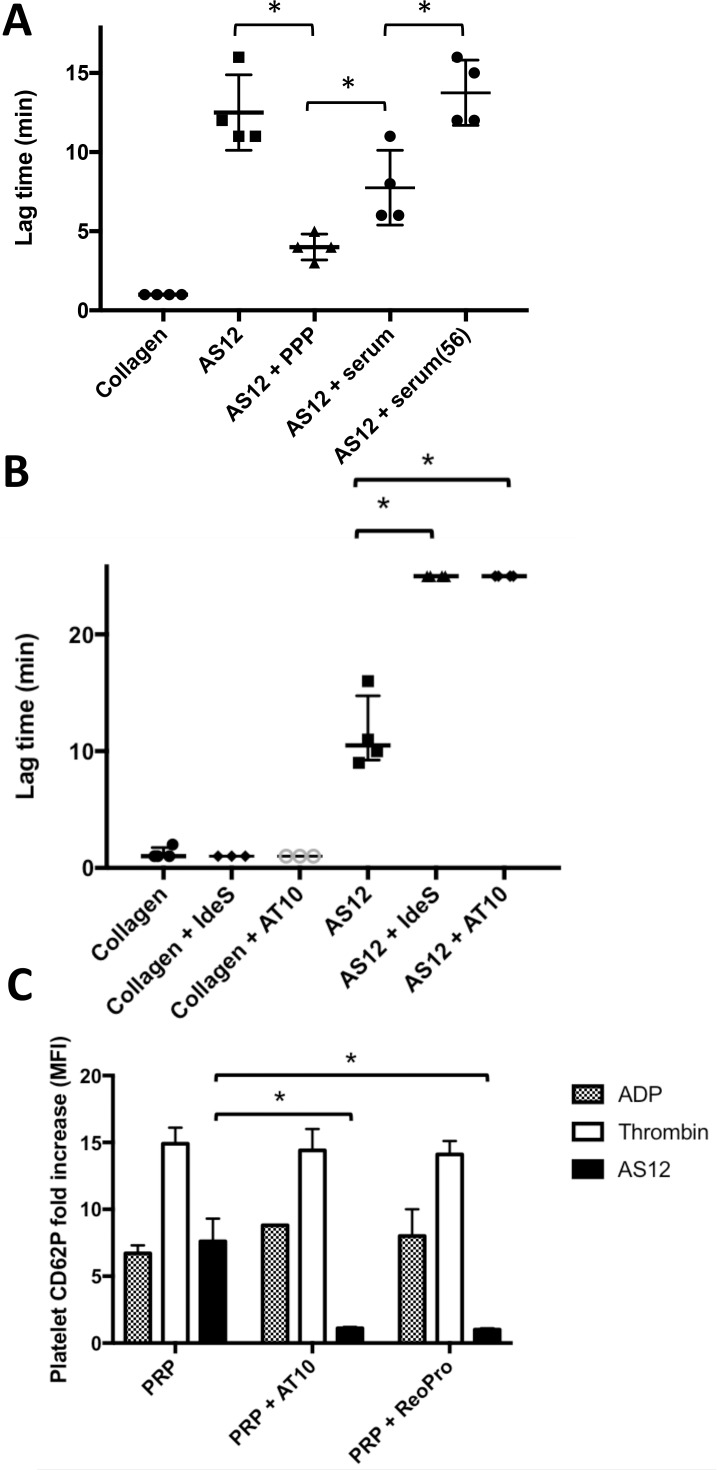
IgG and fibrinogen are critical mediators for C. acnes platelet aggregation.Pretreatment of C. acnes strain AS12 with plasma (PPP) or serum significantly reduces the lag time before aggregation of PRP (A; p = 0.03), while pretreatment with heat-inactivated serum does not reduce the lag time. Inhibition of IgG-mediated aggregation of platelets through pre-incubation of PRP with IdeS and AT10 resulted in significant inhibition in aggregation (B; p = 0.03). IdeS will inhibit IgG mediated signaling through specific cleavage of IgG in the hinge region, while AT10 mediates its effect through FcRγIIA antagonist properties. PRP was pre-treated with Abciximab in order to investigate the importance of fibrinogen in platelet aggregation of C. acnes stimulated platelets (C; CD62P; p = 0.04). All experiments were performed four independent times and presented as medians with range and analyzed using Mann Whitney.